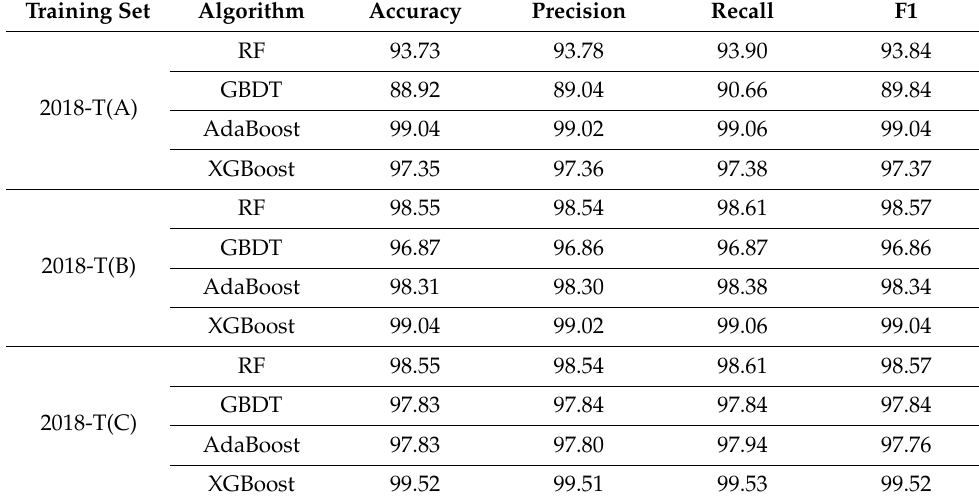
Figure 15. XGBoost performance using CGAN-enhanced sets with different iteration numbers. Table 1. Performance comparison of different algorithms using raw sample sets (%). Training Set